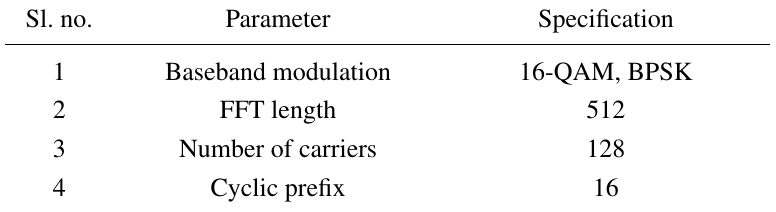
Table 1. Parameters used for generating the OFDM signal. Sl. no.